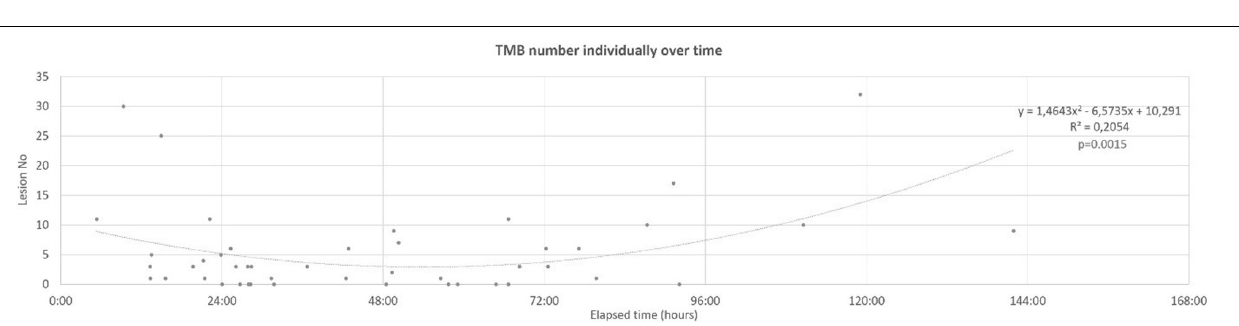
FIGURE 3 | Representative images of nonhemorrhagic/FLAIR lesions in < 24, 24–48, 48–72, and 72 h < groups. All four FLAIR measurements were performed on a 3T Siemens Magnetom Prisma MRI scanner. According to Mayo Clinic Classification, two of the four patients (top right, 77-year-old female; bottom left, 31-year-old male) suffered symptomatic TBI, and two of them (top left, 75-year-old female; bottom right, 27-year-old male) were classified as severe TBI; lesions are indicated by red circles. FLAIR, fluid-attenuated inversion recovery; TBI, traumatic brain injury.